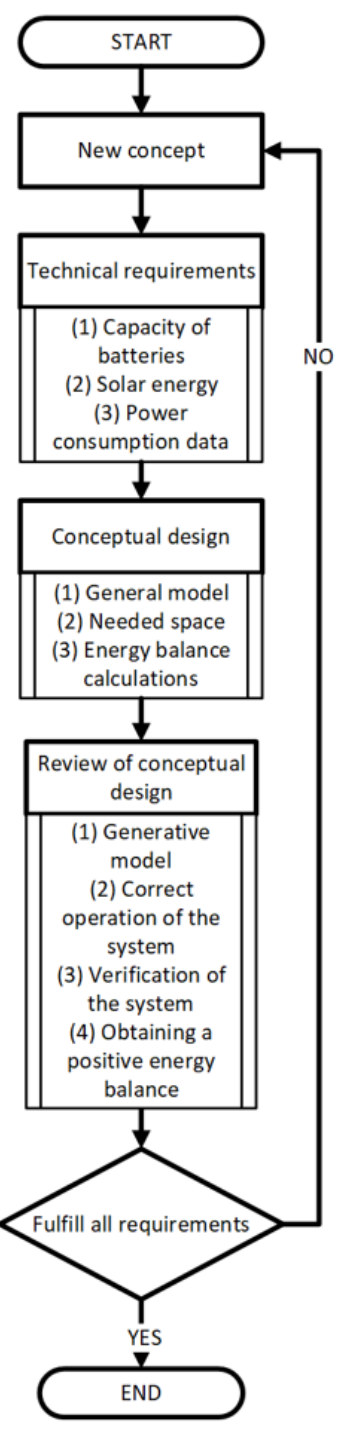
Figure 4. Flow chart of choosing the parameters of the power supply system.